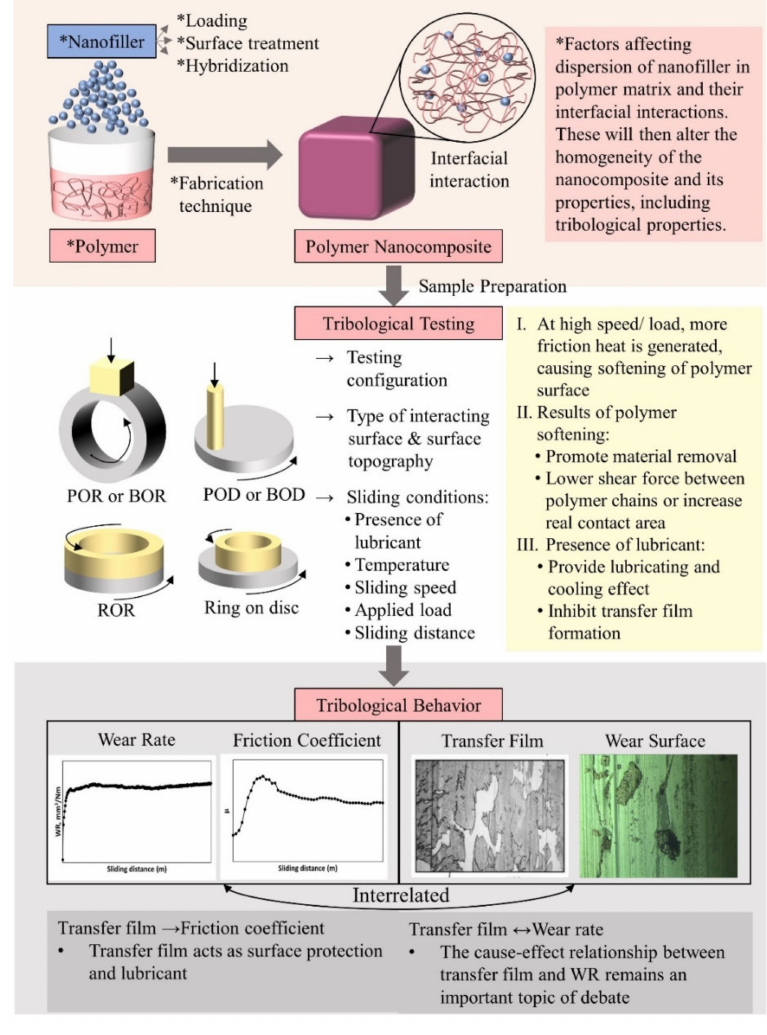
Figure 15. A basic tribosystem for polymer